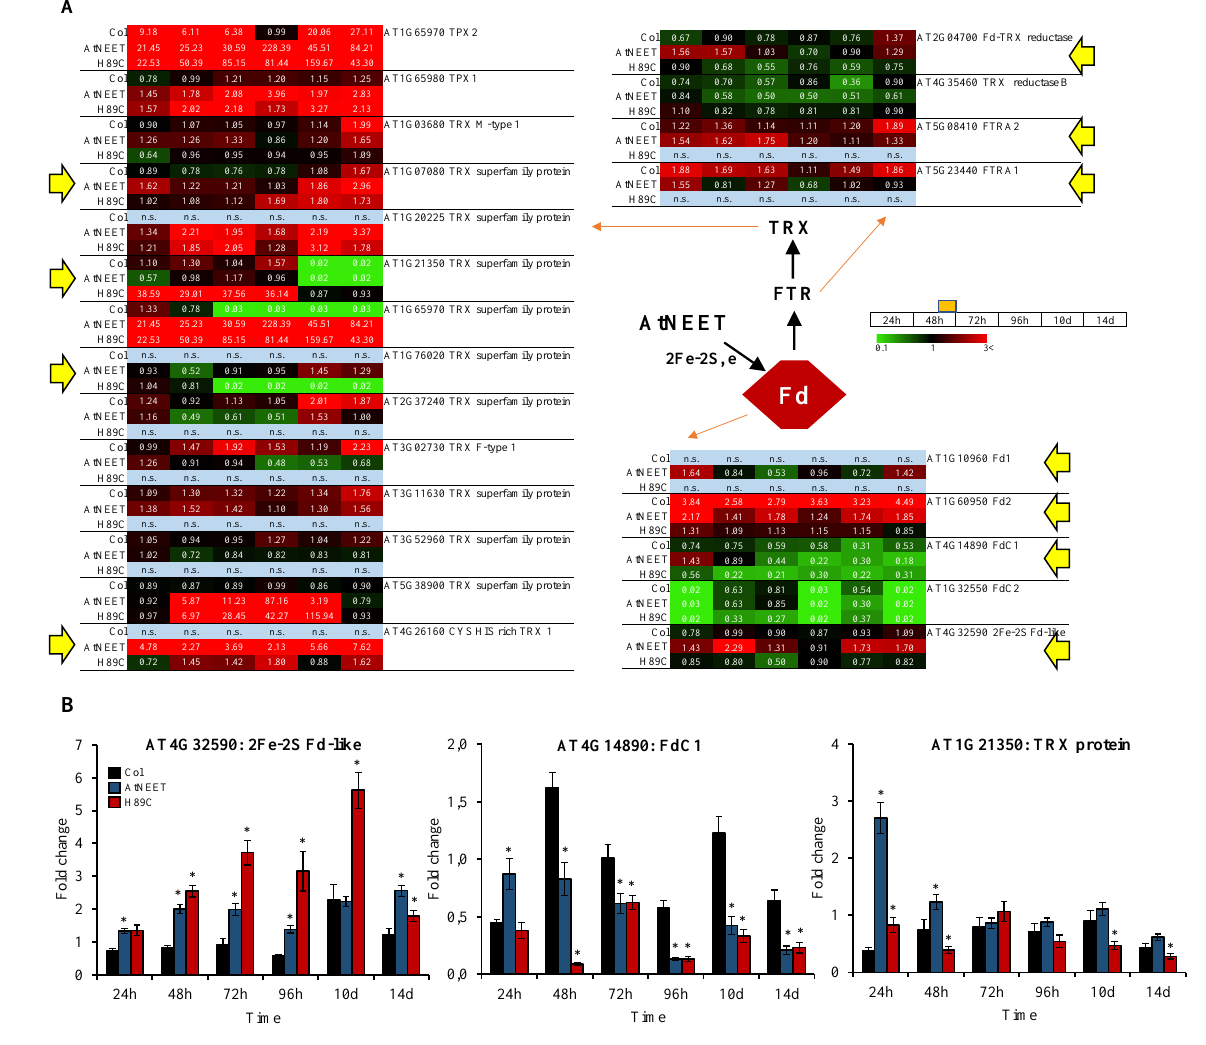
Figure 7. Changes in protein and transcript expression associated with the ferredoxin (Fd), Fd-thioredoxin (TRX) reductase (FTR) and/or TRX during the course of the experiment. ( A ) Pathway and heat maps for the expression pattern of different proteins with a significant change in expression (in at least one time point, compared to time 0 h within each genotype) associated with the Fd-FTR-TRX network of Arabidopsis at the different time points. ( B ) Steady-state transcript expression levels of an 2Fe-2S Fd-like, FdC1 and a TRX protein in Col, AtNEET, and H89C plants at the different time points. Yellow arrows highlight proteins of interest at the different points. All experiments were repeated at least three times with similar results. Asterisks (*) denote statistical significance with respect to control (Col) at p < 0.05 (Student t -test, SD, n = 5). Abbreviations used: Fd, ferredoxin; FTR, ferredoxin-thioredoxin reductase; FTRA1, Ferredoxin/thioredoxin reductase subunit A1; FTRA2, Ferredoxin/thioredoxin reductase subunit A2; n.s., not significant; TRX, thioredoxin; TPX, thioredoxin-dependent peroxidase.